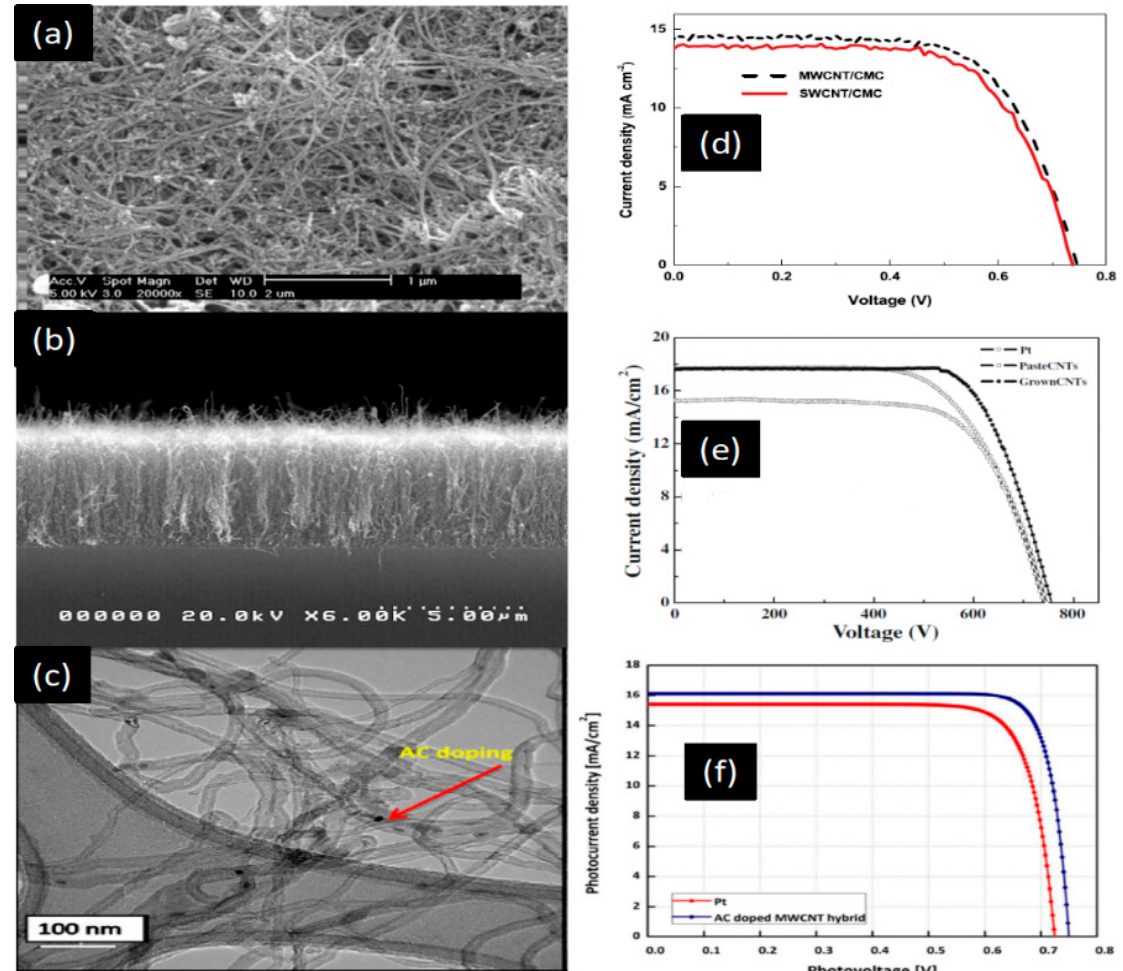
Figure 16. ( a ) SEM and ( b ) cross-sectional SEM image of CVD-grown CNT layer on a soda-lime glass. ( c ) TEM image of AC-doped MWCN composite, SWCNTs ( d ) I-V curve characteristics of SWCNT and MWCNT CEs for DSSCs. Reprinted with permission from Reference [54]. ( e ) I-V curves of DSSCs with